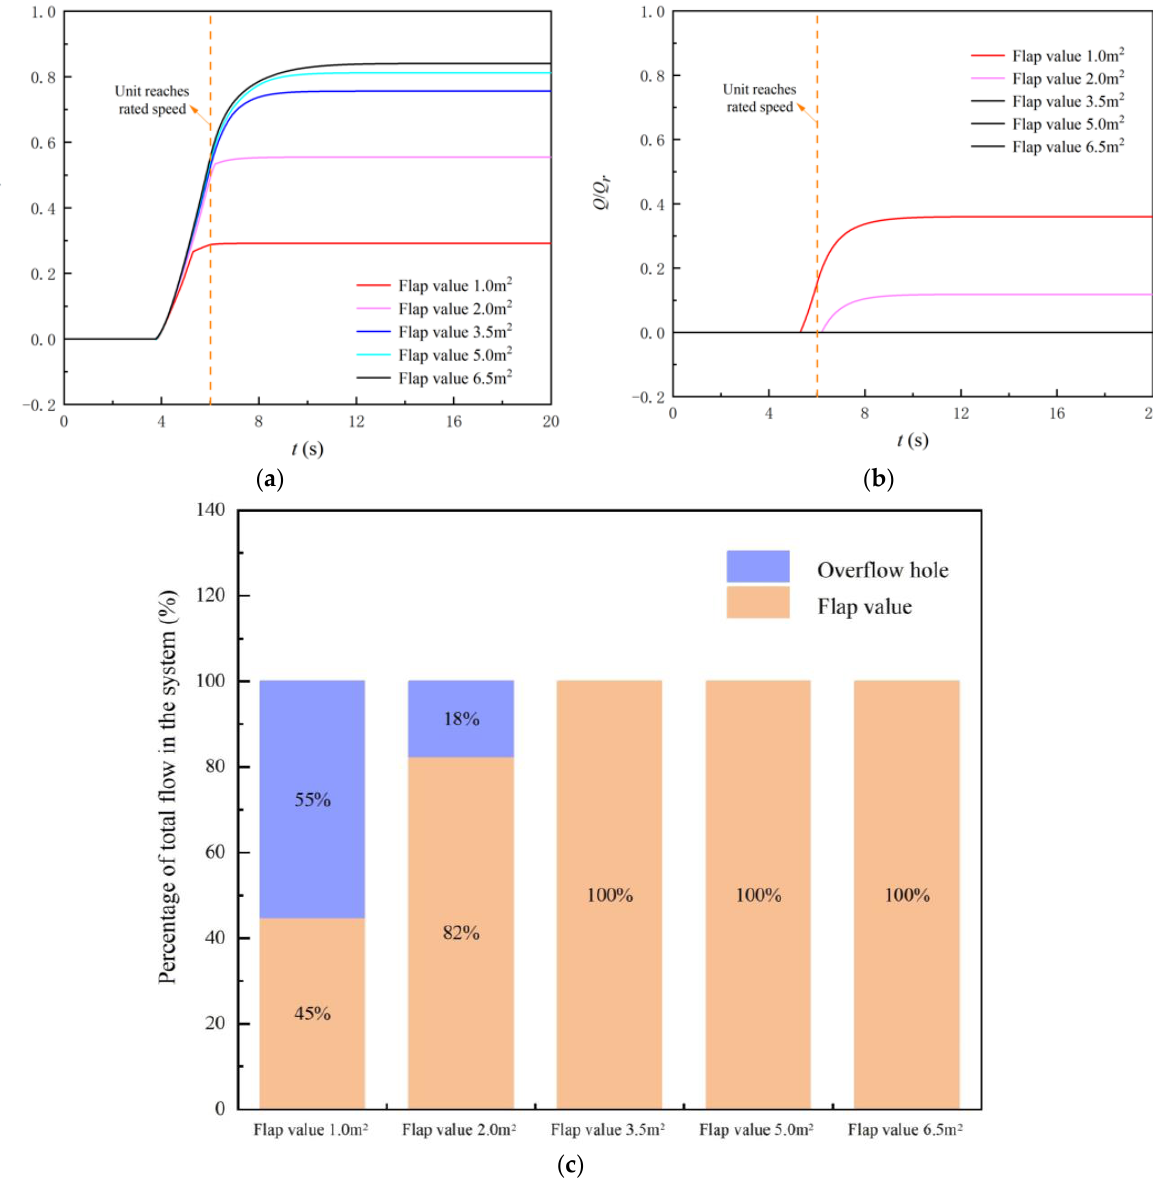
Figure 22. Variations in the outflow of safety auxiliary facilities in the case of restricted OVHO settings. ( a ) FLVA. ( b ) OVH. ( c ) Flow at FLVA and OVHO after completing start-up operations. OVHO (1.27 H m ) for the gate refusal working condition are provided in Figure 23. Accord-